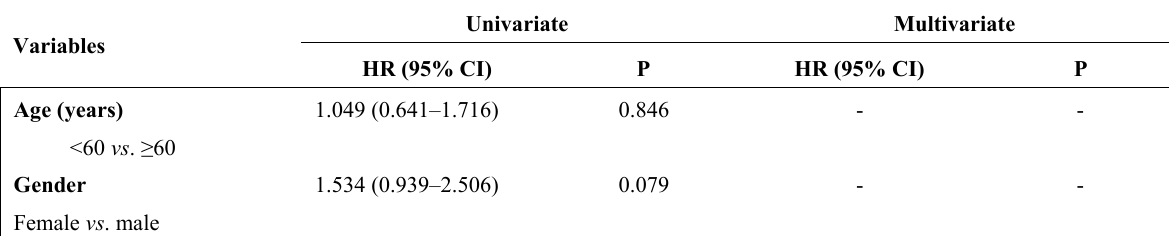
Table 2. Univariate analysis of overall survival in patients with stage II